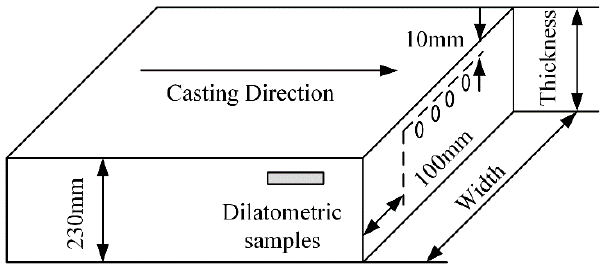
Figure 1. Schematic diagram of the position for samples.